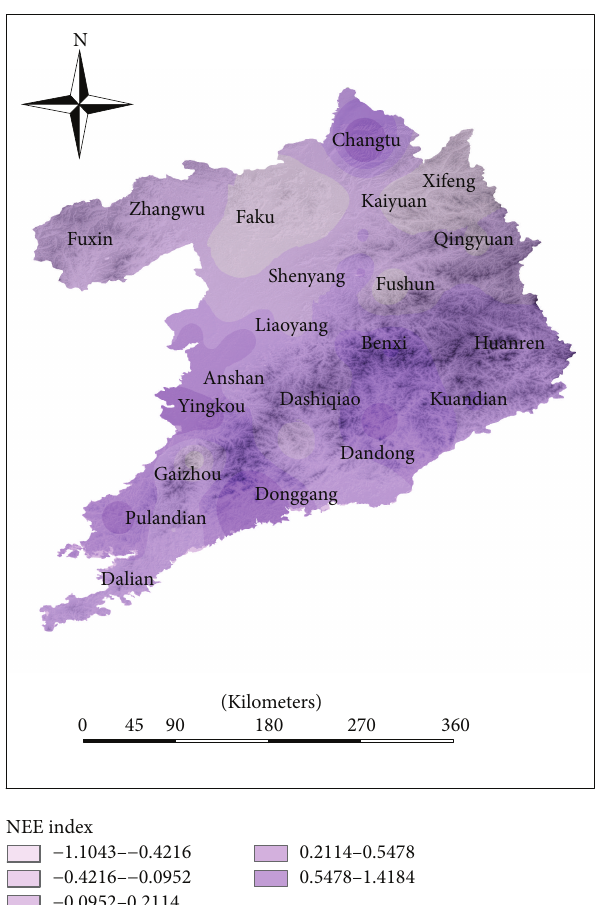
Figure 9: The distribution of socioeconomic evaluation (SE) index in Shenyang-Dalian urban